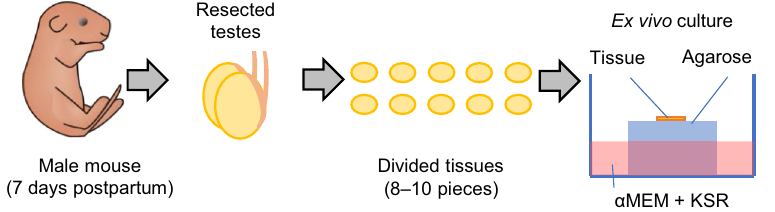
Figure 1. Ex vivo testes organ culture. Schematic representation of ex vivo testes organ culture. Testes were obtained from 7 days postpartum male mice. Resected testes were cut into 8–10 pieces, and then each piece was placed on an agarose gel block immersed in α -MEM medium containing KSR (KnockOut Serum